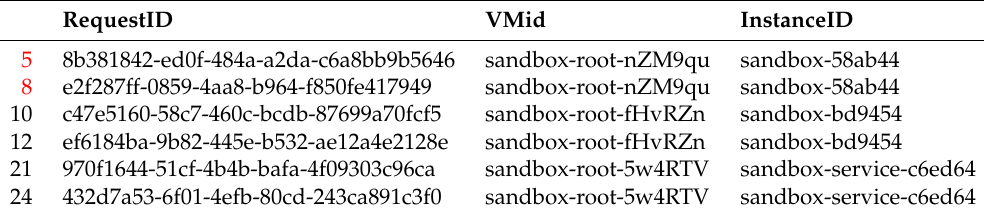
Table 8. Dataset Extract Re-Used VMs—II.